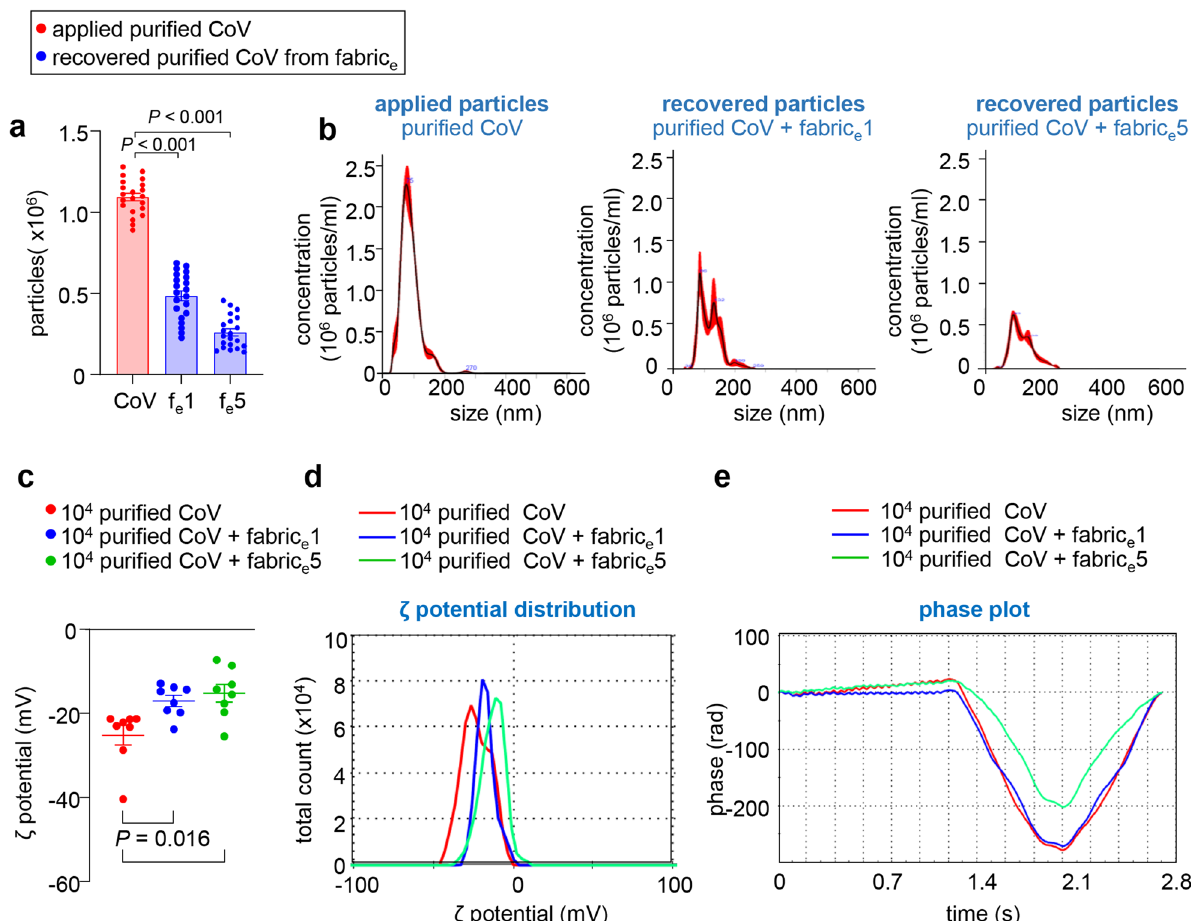
Figure 4. Zeta potential and nanosight tracking analysis of the purified coronavirus following contact with and retrieval from the electroceutical fabric. ( a ) Absolute quantification of viral particles recovered from the fabric after treatment with f e . A two-fold and four-fold reduction in the recovered viral number was observed after 1- and 5-min treatment, respectively. ( b ) Viral particle number was quantified using NTA. One hundred microliters of the purified CoV were spotted on 1.5 cm discs of electroceutical fabric and recovered using incomplete EMEM, after 1 or 5 min of contact with the fabric. ( c – e) Changes in viral zeta potential and affiliated parameters after contact with the fabric for 1 min or 5 min. Data are mean ±